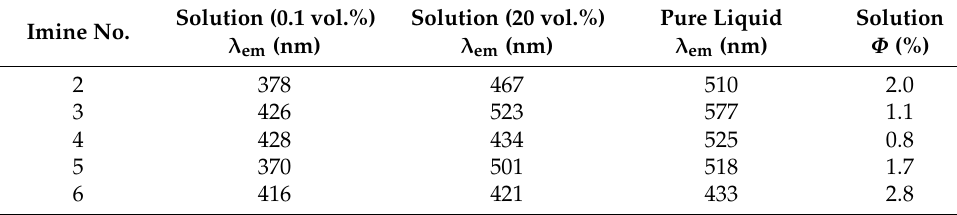
Table 1. Emission wavelengths and quantum yields of imines 2 - 6 . Imine No.